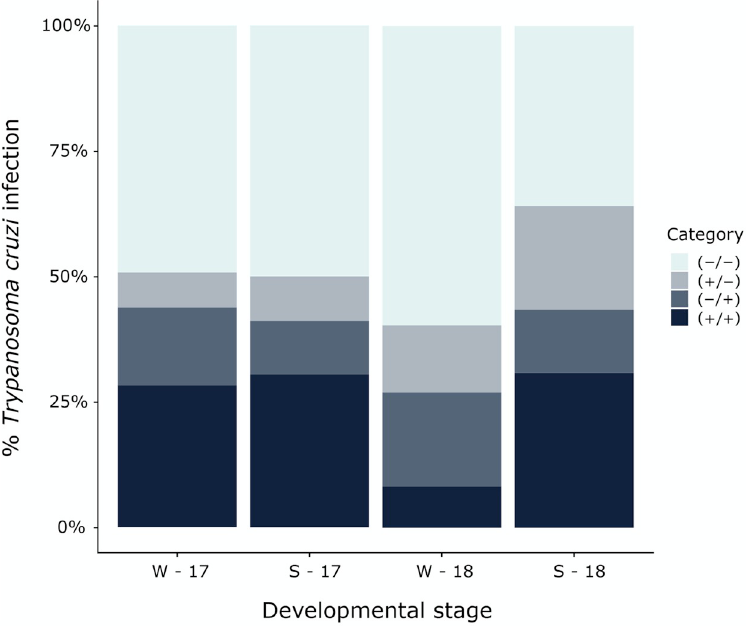
Fig 2. Percentage of Mepraia spinolai (all development stages combined) with presence of Trypanosoma cruzi DNA detected by PCR in fecal/urine samples during two laboratory feedings, in the four collecting events (W-17, S-17, W-18, S-18). The four types of PCR results are shown: both fecal samples positive (+/+), first fecal sample negative and second positive (-/+), first fecal sample positive and second negative (+/-), and both fecal samples negatives